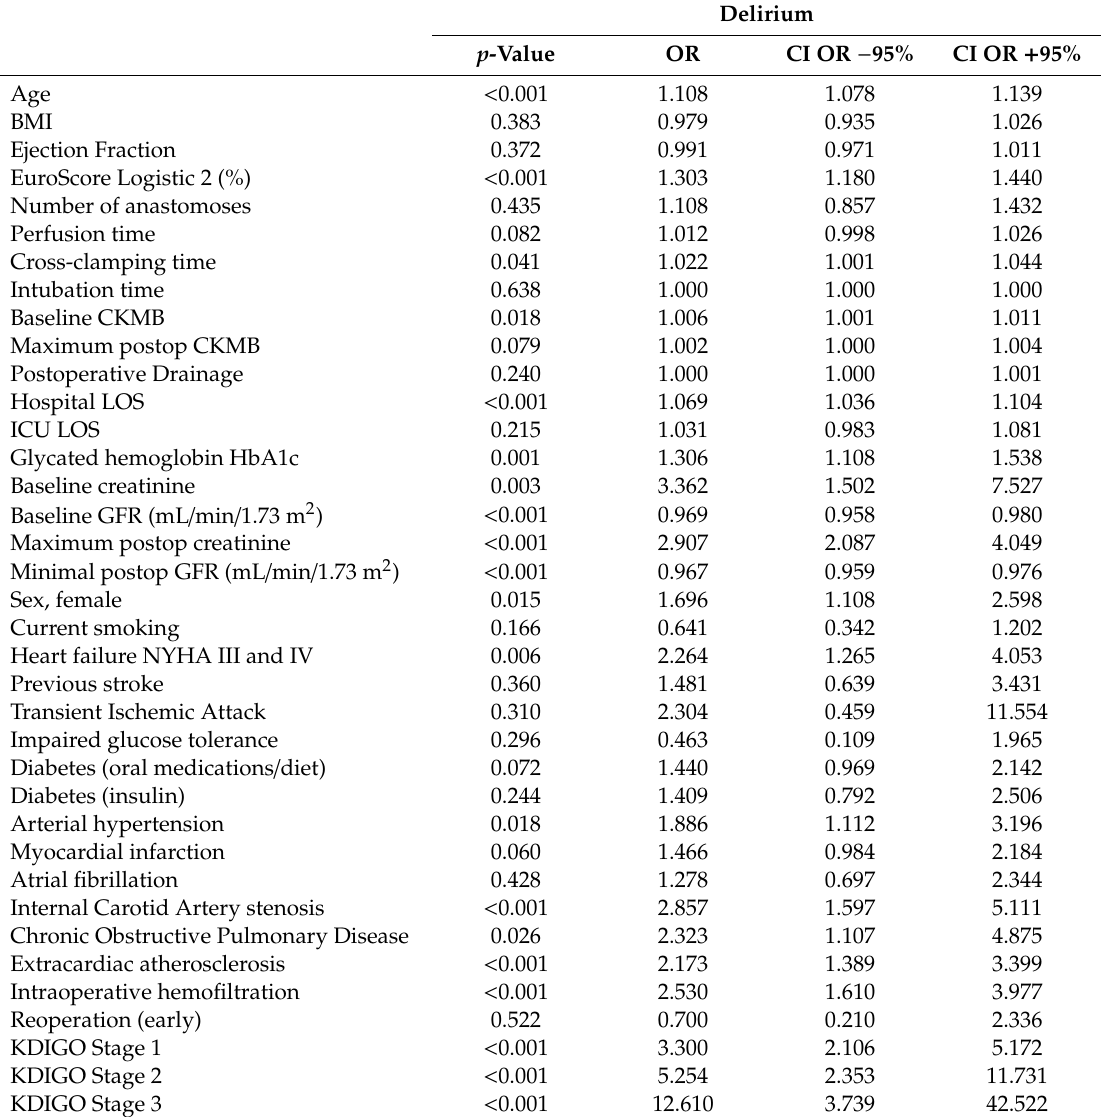
Table 3. Univariable analysis for POD development after